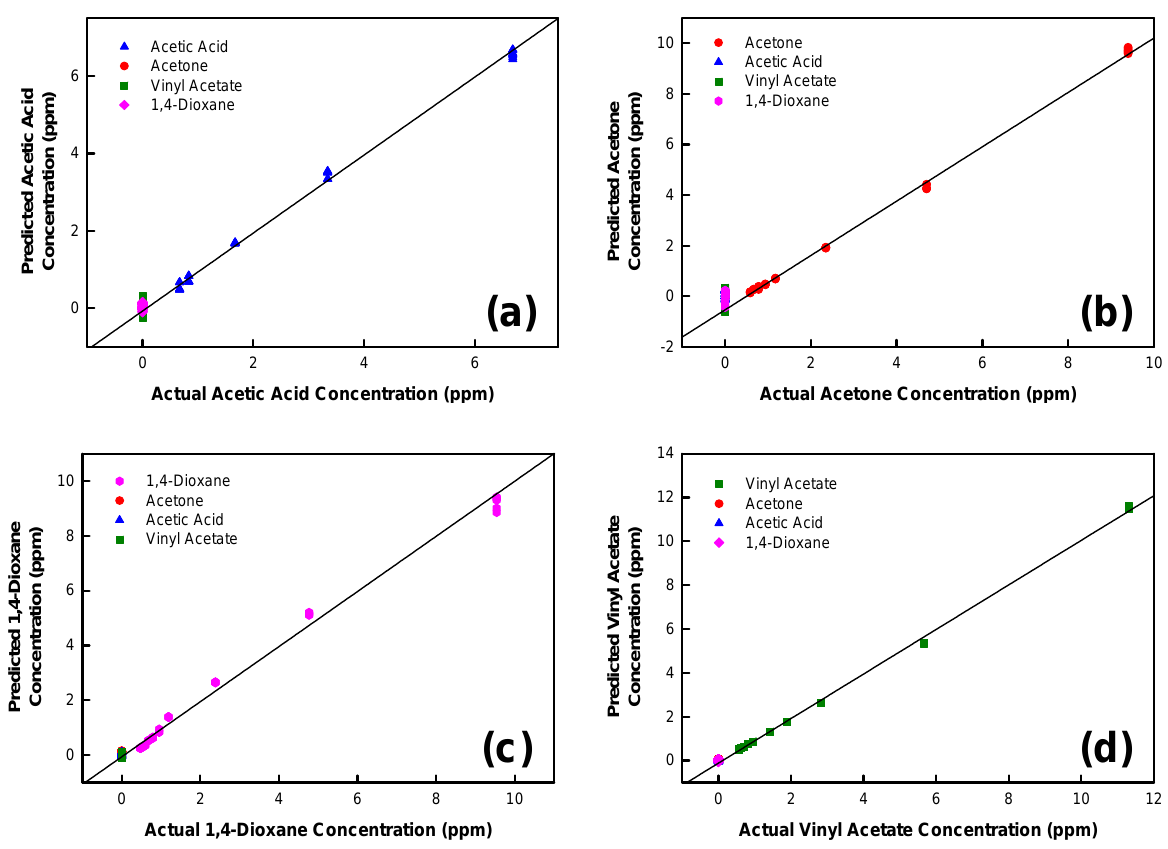
Figure 10. The predicted concentration value plotted against the measured concentration value using (a) acetic acid-specific algorithm; (b) acetone-specific algorithm; (c) 1,4-dioxane-specific algorithm; and (d) vinyl acetate-specific algorithm. Classification for each analyte is based on four